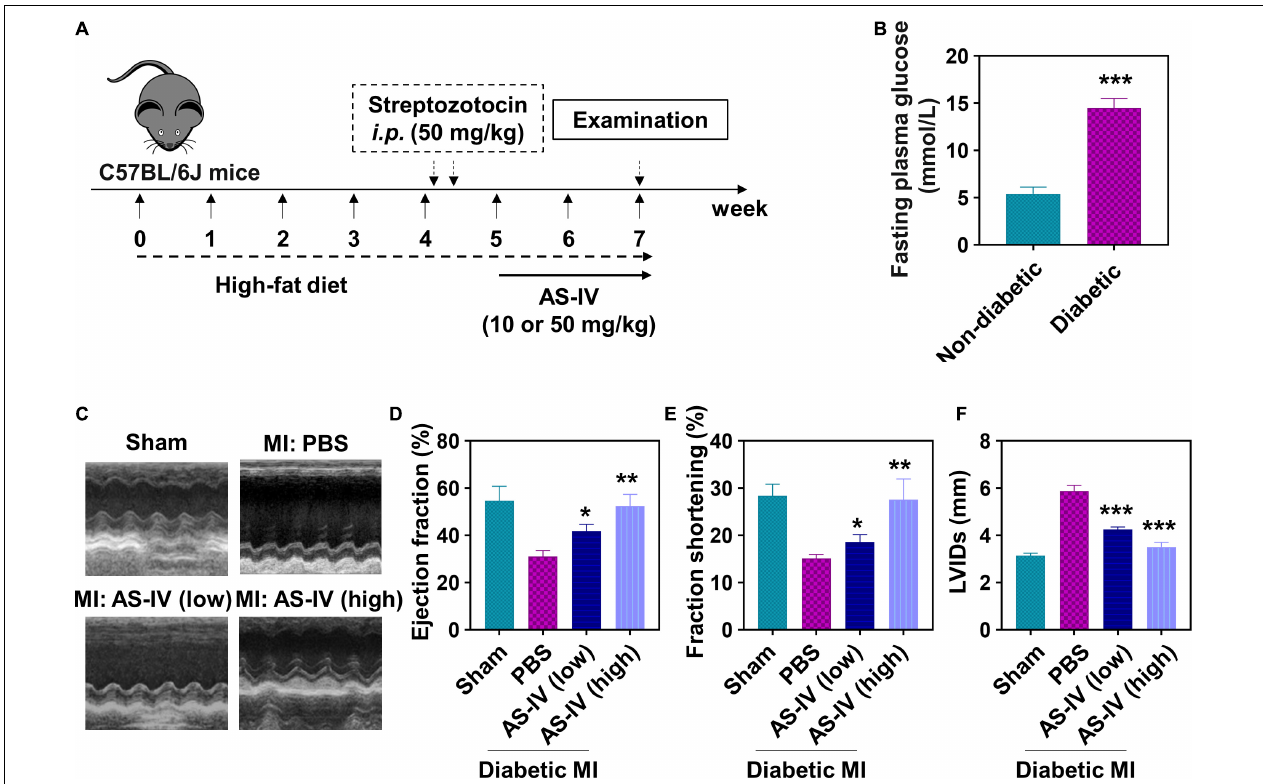
FIGURE 3 | Effect of AS-IV on cardiac function in post-MI diabetic mice. (A) Experimental protocol. C57BL/6J mice were fed high-fat diet for 4 weeks prior to overnight fasting. Mice were then given 100 µ l solution of streptozotocin (50 mg/kg body weight/day) for two consecutive days. After confirming the characteristic of diabetes mellitus, myocardial infarction models were established, and the mice were orally administrated with AS-IV (10 or 50 mg/kg/day) for 2 weeks. (B) Detection of fasting plasma glucose (FPG) with or without high-fat diet and streptozotocin administration. Data represent means ± SD. *** p < 0.001, n = 6 biologically independent mice. (C) Representative M-mode echocardiographic images from four respective mouse groups. Cardiac function was assessed using echocardiography at the 2 weeks post-myocardial infarction (MI). (D) Ejection fraction. (E) Fractional shortening. (F) LVIDs, left ventricular internal dimensions during systole (end-systolic diameter). Data represent means ± SD. * p < 0.05; ** p < 0.01; *** p < 0.001, versus the PBS group, n = 6 biologically independent